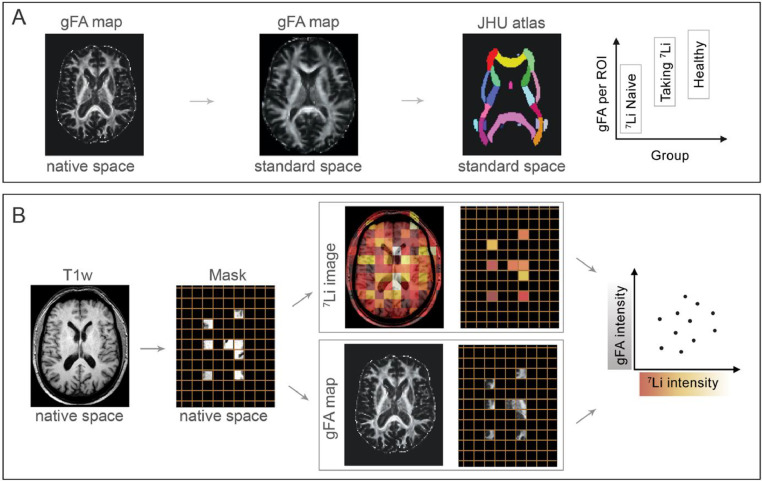
Schematic outline of processing pipeline. (A) gFA ROI analysis between groups was performed by transforming the gFA maps into standard space and applying the John Hopkins University (JHU) atlas. (B) The gFA ∼ lithium analysis for each subject was performed in native space at the resolution of the lithium image. The T1w image was used to identify lithium voxels containing a certain percentage of white matter, which essentially creates a mask. The mask was applied to both the gFA map and the 7Li-MRI image. Finally, mean gFA in each mask voxel was plotted against the 7Li signal. Hence, each data point corresponds to a lithium voxel in a subject.